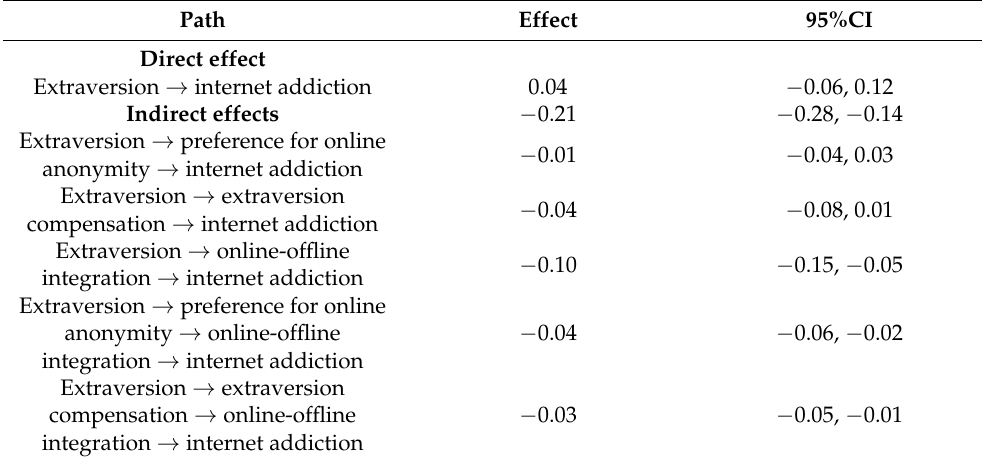
Figure 2. Results of the serial mediation model from extraversion to internet addition. Coefficients are standardized betas, * p < 0.05, ** p < 0.01 Table 2. Bootstrapping estimated effects and 95% confidence intervals (CIs) for the mediation model.